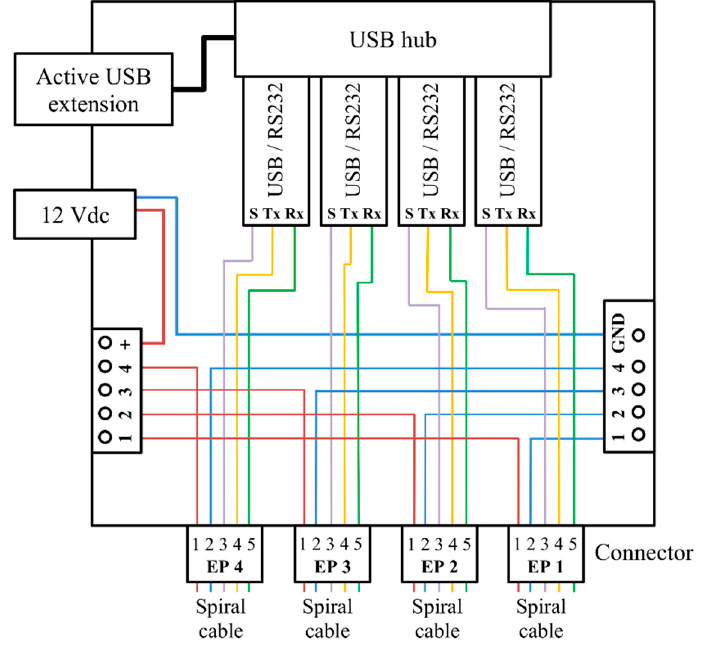
Figure 2. Schematic overview of the hardware interface box.